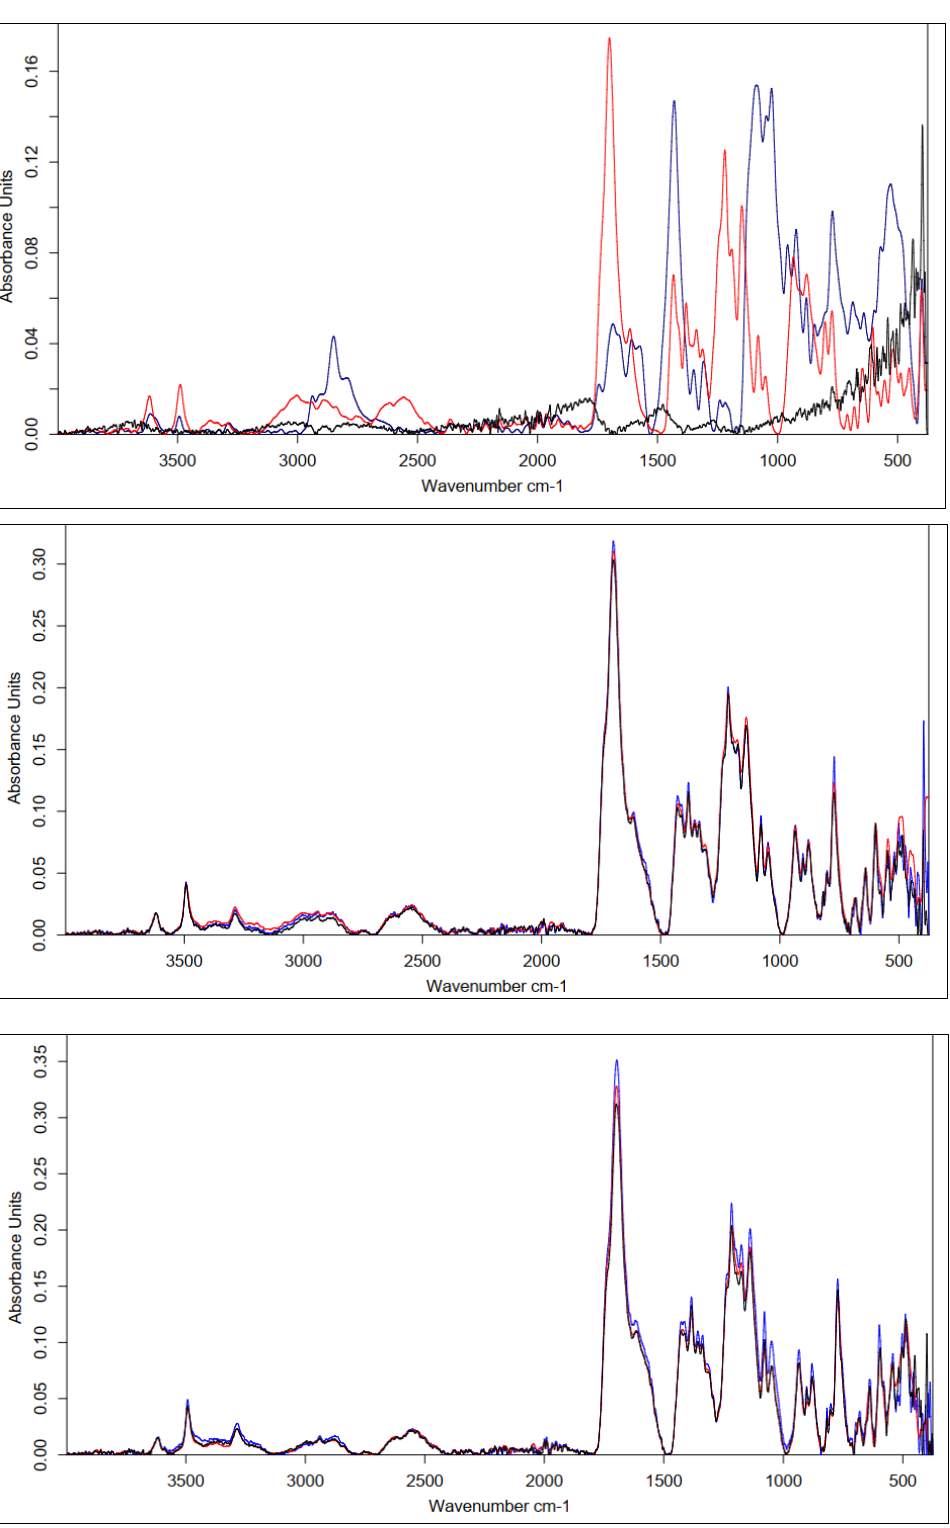
Figure 15. Comparison of IR spectra obtained for carbon nonwovens coated with hyaluronic acid at concentrations of 0.5% ( top ), 1% ( center ), and 2% ( bottom ) and cross-linked with different cross-linking agents (5% CA—black line; 20% CA—red line; BDDE—blue line).